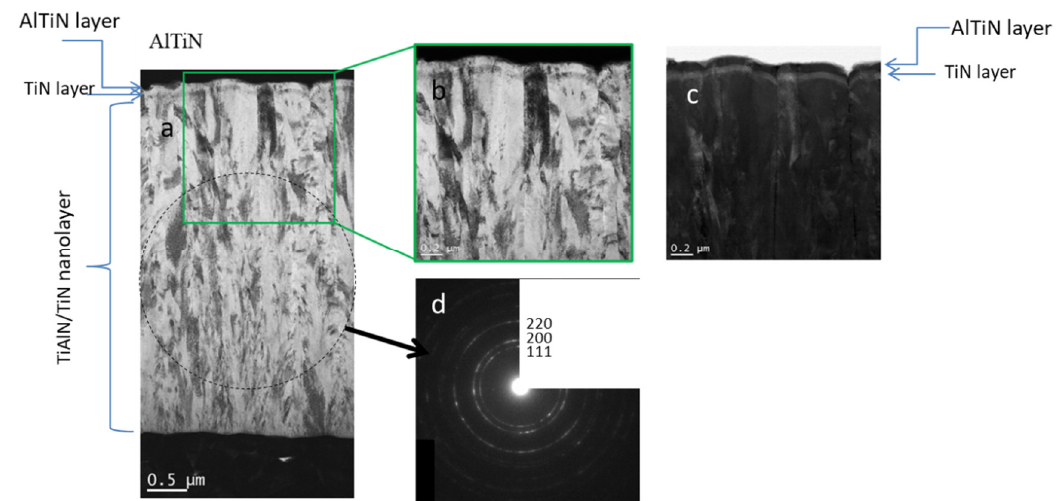
Figure 9. The cross-sectional BF-STEM image at lower ( a ) and at higher magnification ( b ). STEM image in Z-contrast mode ( c ) and the corresponding electron diffraction ( d ) of TiN/AlTiN coating.